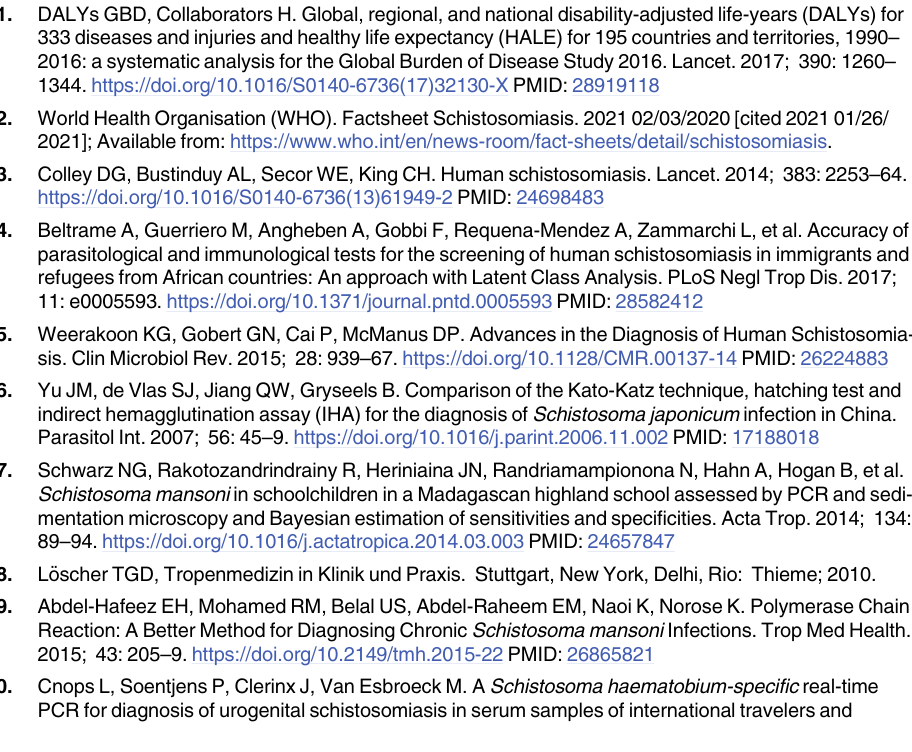
S1 Fig. Diagram with Schistosoma positive Sera of Panel 1 and 2. S2 Fig. Diagram with Schistosoma negative Sera of Panel 3, 4 and